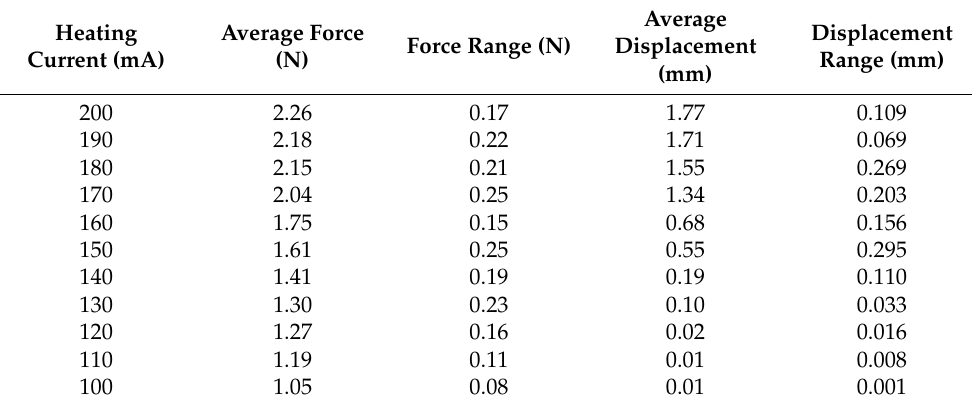
Table 3. Statistical properties of the measurement data with different heating currents. Sample diameter, 100 µ m.